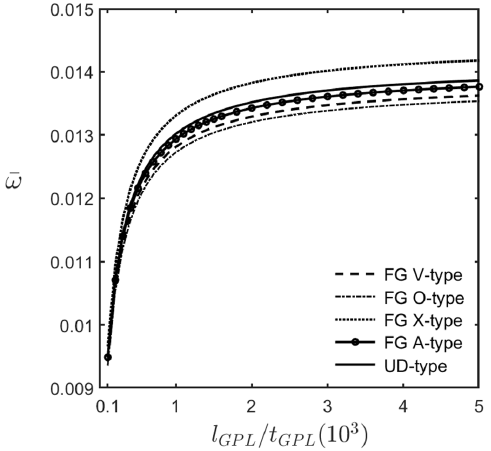
Figure 9. Variations in the dimensionless fundamental frequencies of an FG-GPLRC cylindrical mi- microshell with the length–to–thickness ratio of GPL for different GPL distribution patterns, for which ( ˆ m , ˆ n ) = (1, 2), ˆ l / h = 1.0, R / h = 20, L / R = 5, and W ∗